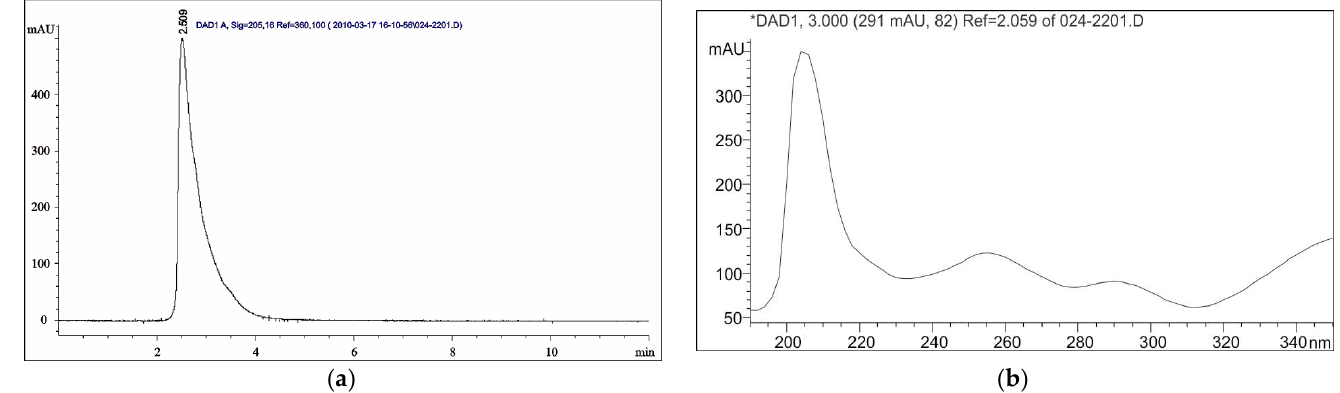
Figure 6. ( a ) HPLC chromatogram of piroxicam, ( b ) UV spectrum of piroxicam from DAD detec-